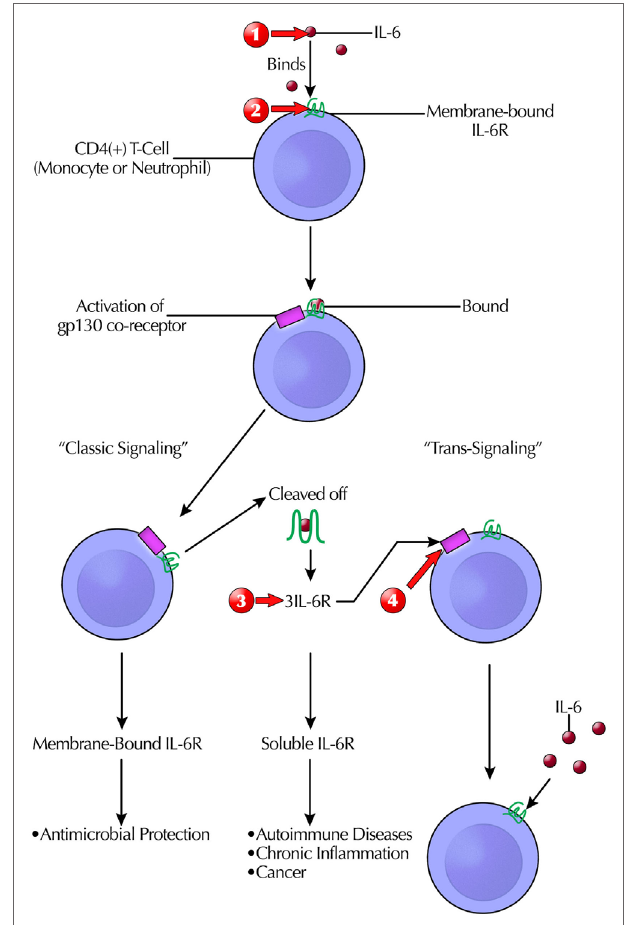
FiGURe 3 | Simplified schema of the complicated targeting IL-6 actions at the receptor binding and signaling/transduction level that give rise to its pleotrophic effects. Only after formation of the three-way complex [IL-6, IL-6R, and glycoprotein 130 (gp130)] is IL-6 signaling initiated. Although gp130 is ubiquitously expressed, fewer cells express IL-6R. Clinically available therapeutic modalities target IL-6 or IL-6R. Another option in clinical trials is blocking sgp130Fc, which does not interfere with host antibacterial defenses. This prevents IL-6 trans-signaling, which is pro-inflammatory. Therapeutic intervention sites are marked with red arrows as follows: (1) anti-IL-6: siltuximab/elselimomab/clazakizumab; (2) anti-mIL- 6R α : tocilizumab/basiliximab/sarilumab; (3) anti-sIL-6R and sIL-6R: sarilumab/tocilizumab; and (4) anti-spg130: sgp130Fc. Abbreviations: STAT, signal transducer and activator of transcription; MAPK, mitogen-activated protein kinase; PI3K, phospitidylinositol-3 kinase; AKT, protein kinase